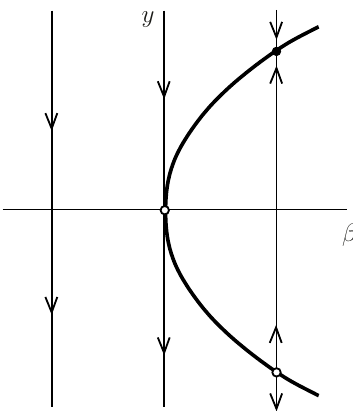
Figure 22. Saddle-Node bifurcation in the system _ y = (cid:12)